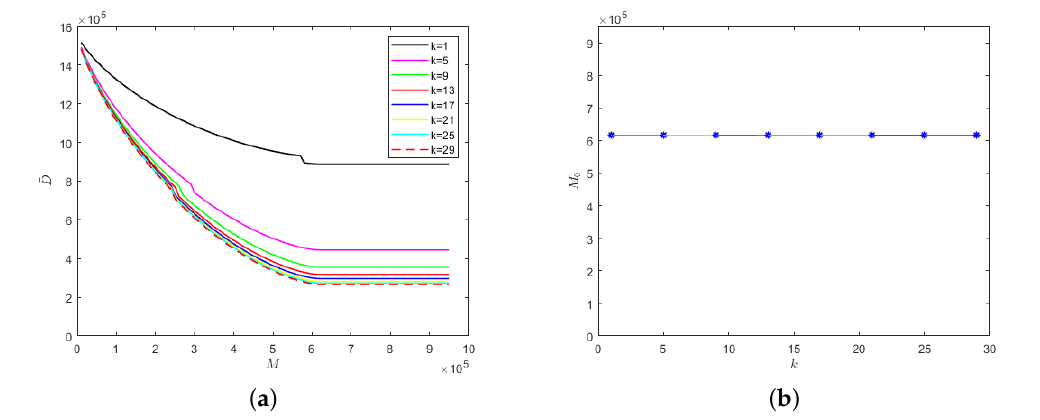
Figure 7. With the fixed parameter k = 5: ( a ) evolution results of the number of deaths in regard to medical resources; ( b ) the relationship between safe medical resources and the k